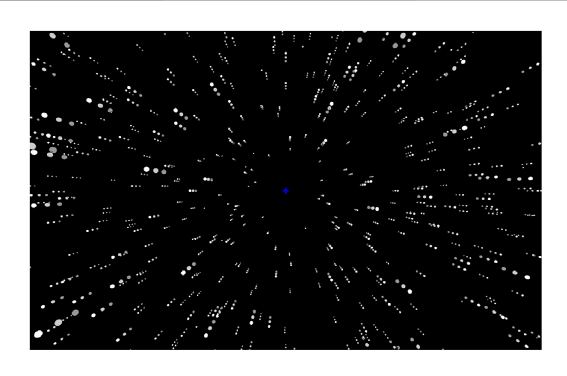
Schematic view of the optic fl ow stimulus. Successive frames were superimposed to give the impression of expanding or contracting